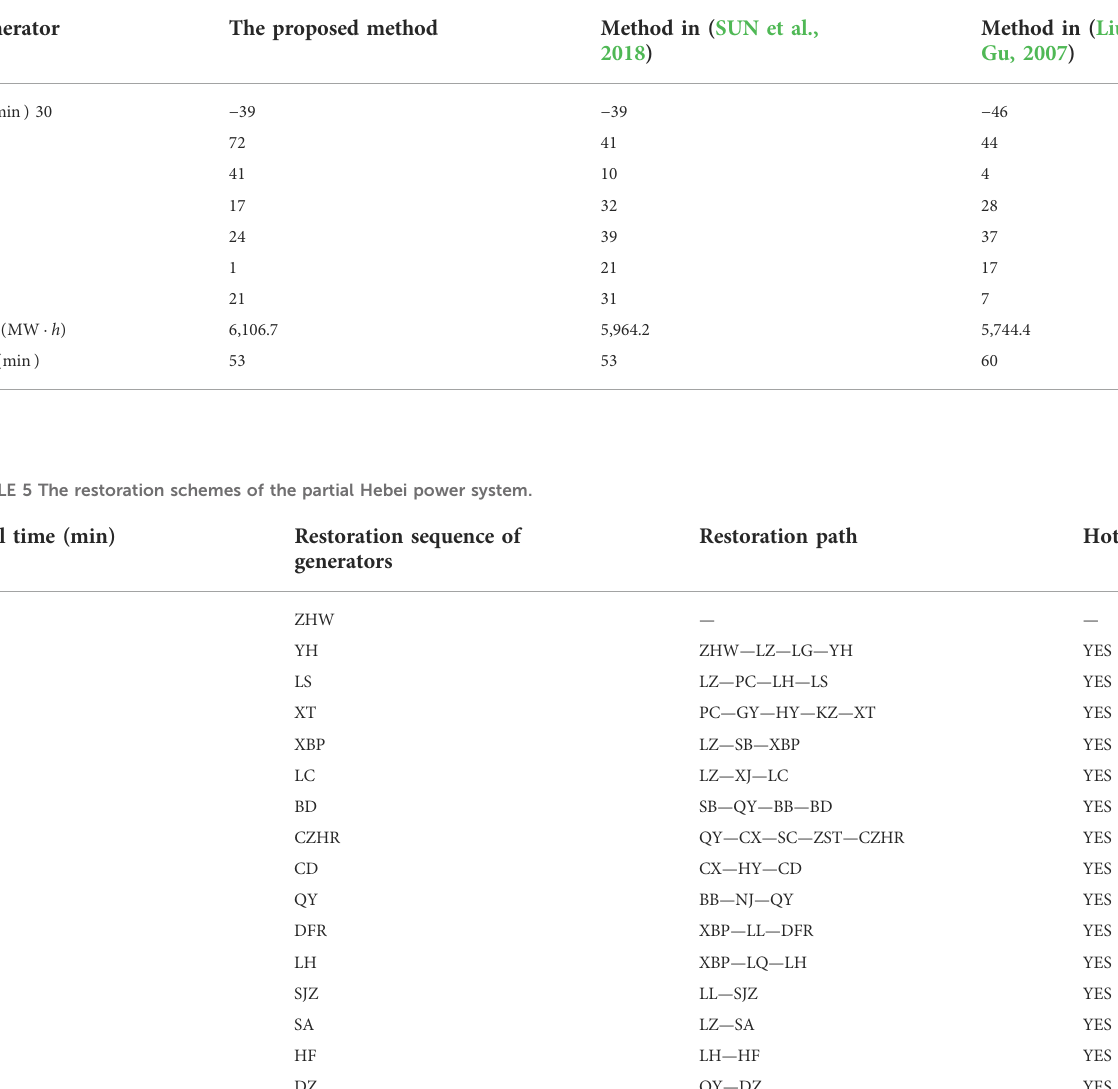
TABLE 4 Results provide by different